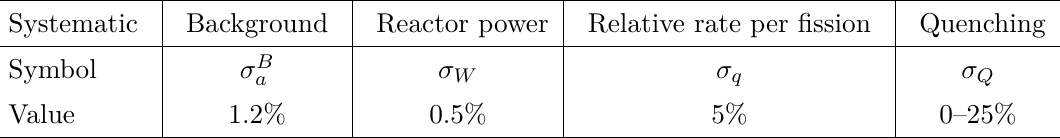
Table 1 . Systematic uncertainties used in our analysis. See text for